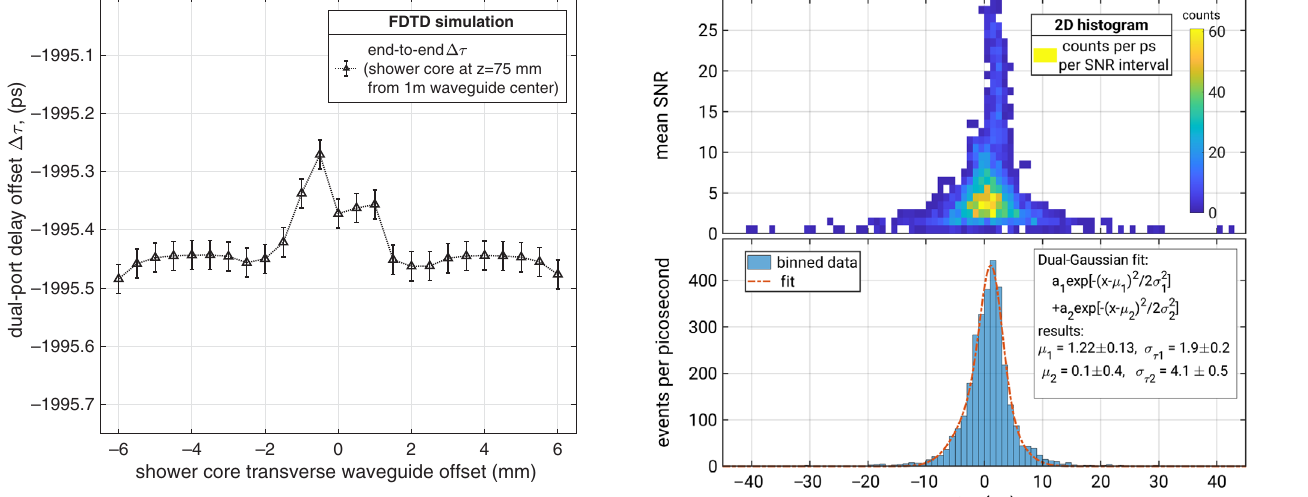
FIG. 14. FDTD simulation of the delay between the dual outputs of a 1-m long waveguide with a shower core offset 75 mm from the center, as a function of the transverse position of the shower core.